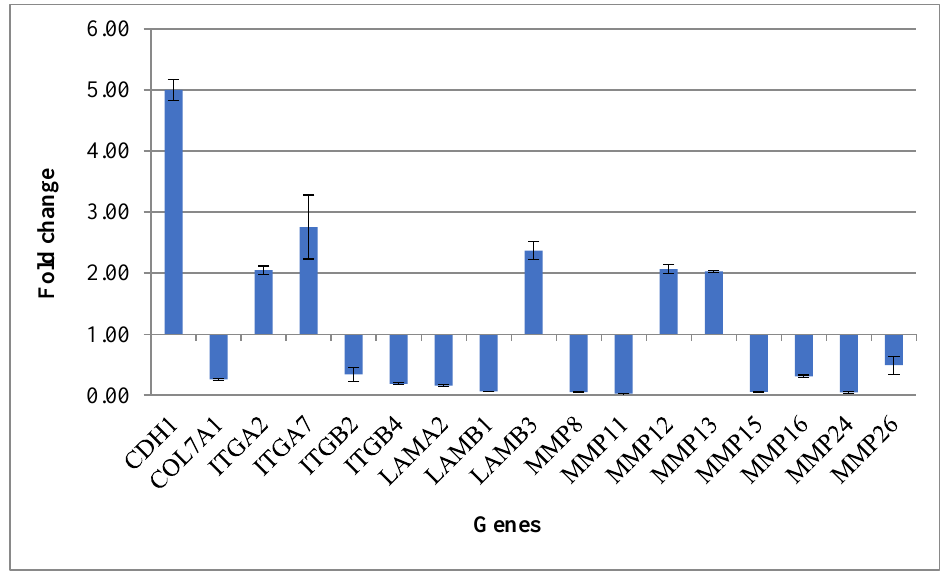
Figure 2. Gene expression profile of fibroblasts treated with cyclosporine A 1000 ng/mL.